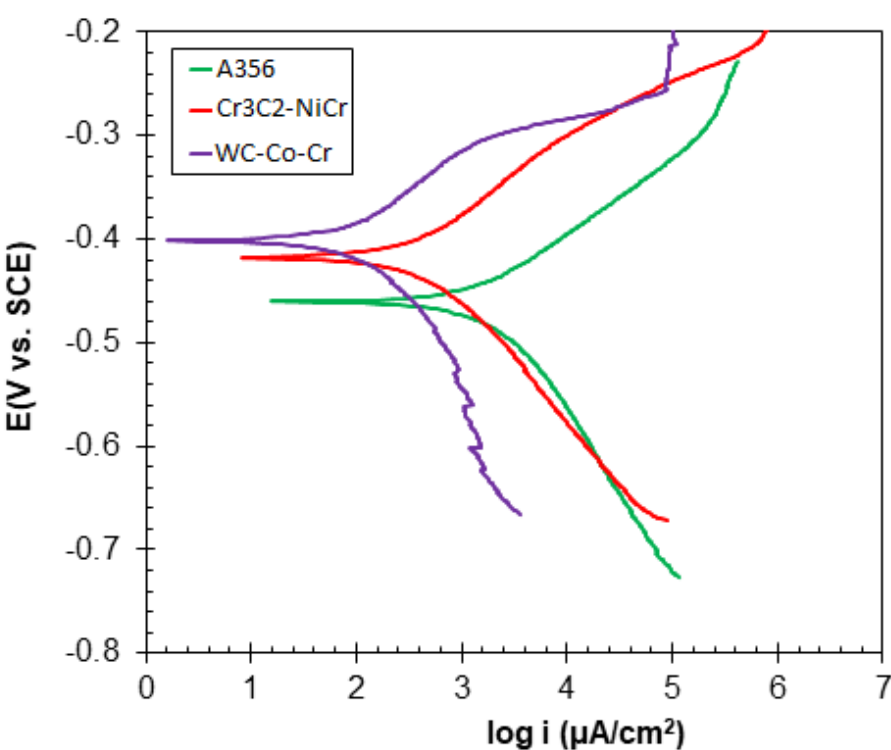
Figure 17. Potentiodynamic polarization curves of A356 substrate, Cr 3 C 2 -NiCr, and WC-Co-Cr coatings immersed in a one molar H 2 SO 4 solution for 3600 s.